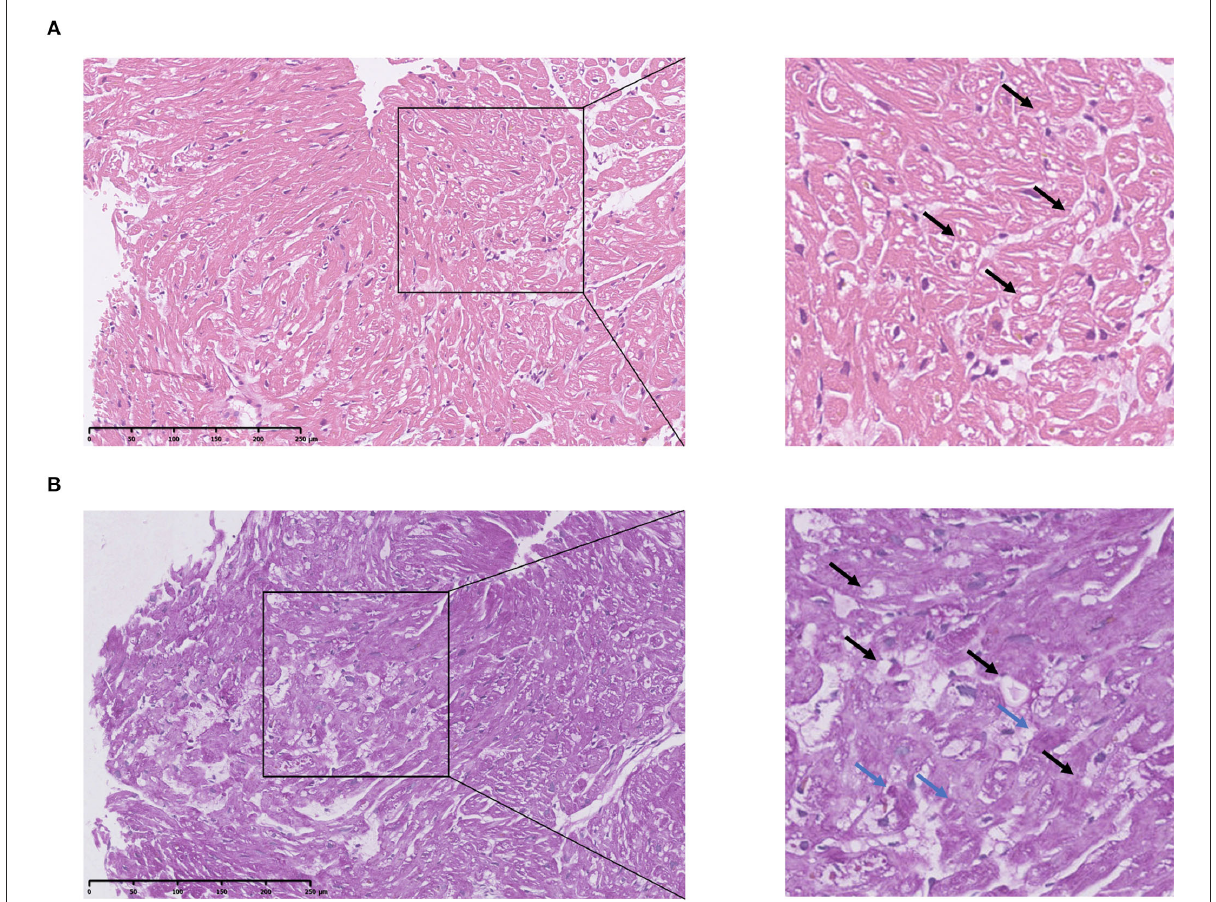
FIGURE3 Pathological analysis of patient’s cardiac muscle specimen. (A) HE staining of patient’s heart tissue. The square shows destructed cardiac cell structure. Arrows indicate small vacuoles within cells. (B) PAS staining of patient’s heart tissue. Blue arrows indicate glycogen disposition within the muscle fiber. Black arrows indicate small vacuoles within